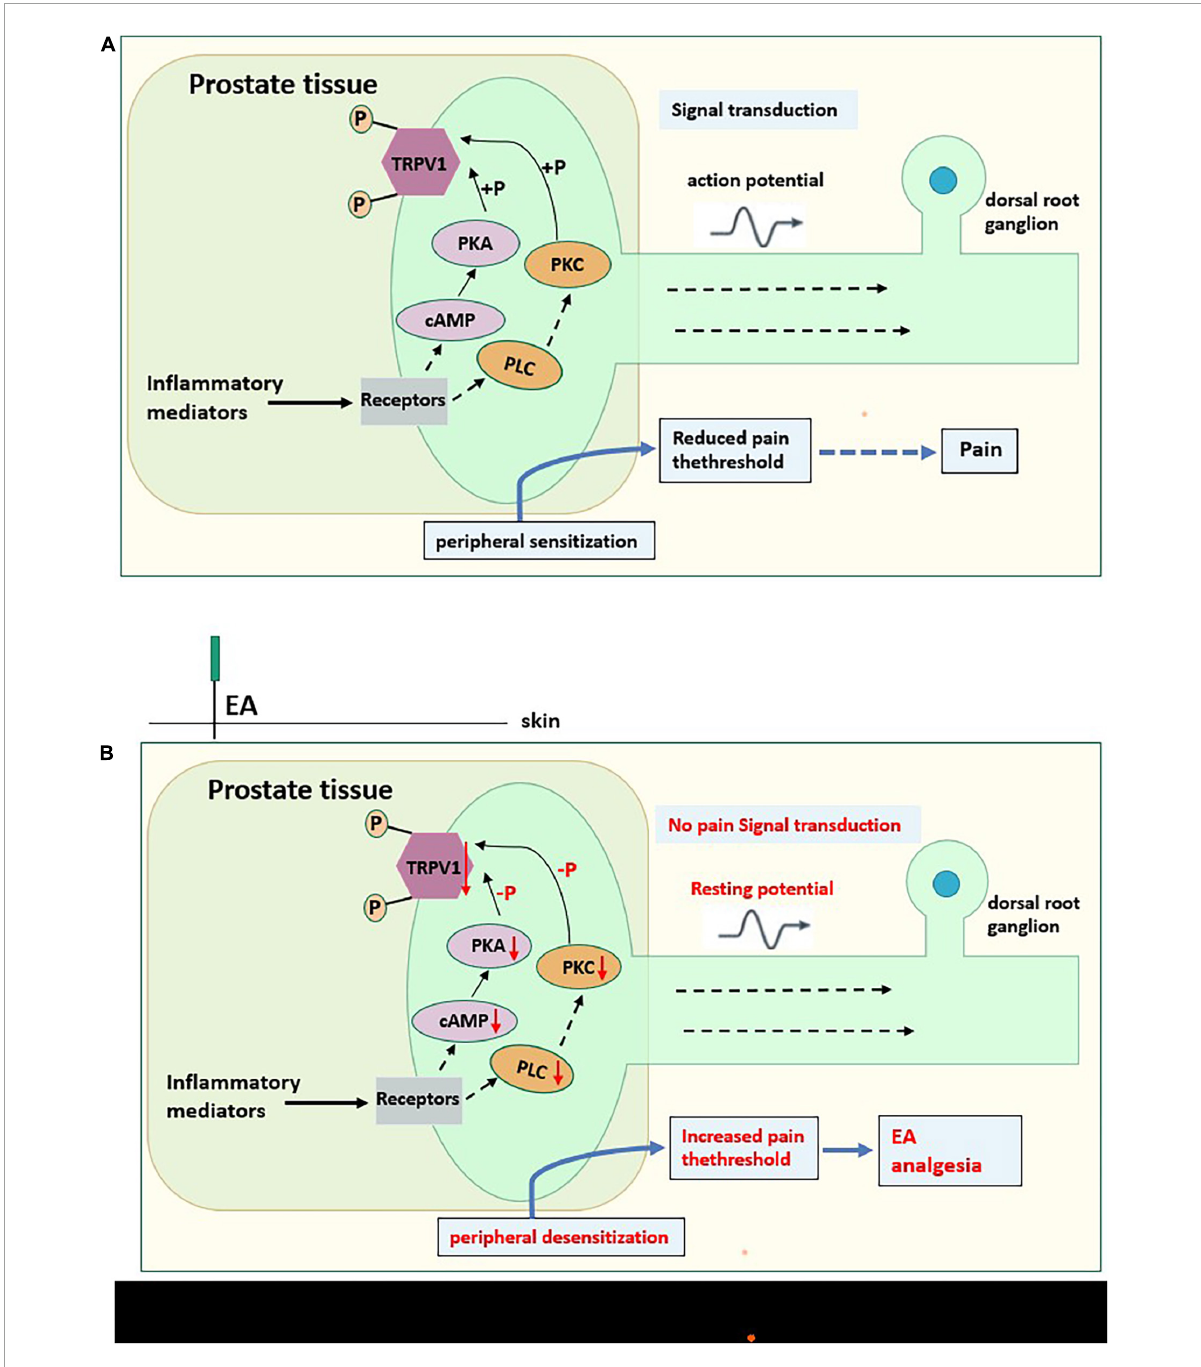
FIGURE10 (A) The possible Pain-related mechanism diagram of CP/CPPS. Prostate tissue of CP/CPPS model rat produces a variety of inflammatory mediators (sensitizers), which act on homologous receptors expressed by nociceptors to activate the cAMP-PKA pathway and PLC-PKC pathway of intracellular signal transduction. These pathways can phosphorylate TRPV1, causing peripheral sensitization, converting chemical signals into electrical signals, then transmitting to the central system, and reducing the pain threshold. (B) The possible analgesic mechanism diagram of EA on CP/CPPS rats. EA on acupoints may interfere with the activation of the cAMP-PKA pathway and PLC-PKC pathway, hindering intracellular signal transduction, reducing the phosphorylation of TRPV1, then causing peripheral desensitization, increasing the pain threshold, and do not transmit noxious stimulation to the central system, to effectively for pain relief. “ (cid:57)(cid:57)(cid:75) ”Directly acting on downstream substances,“ → ” Indirect action on downstream